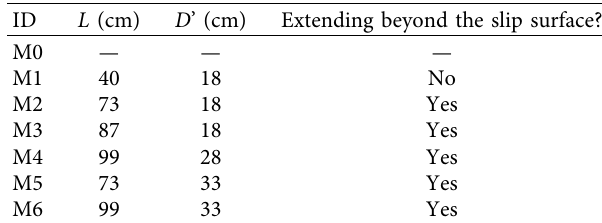
Figure 2: The retaining wall model system: (a) elevation and (b) plan view. Table 1: The arrangement of physical model